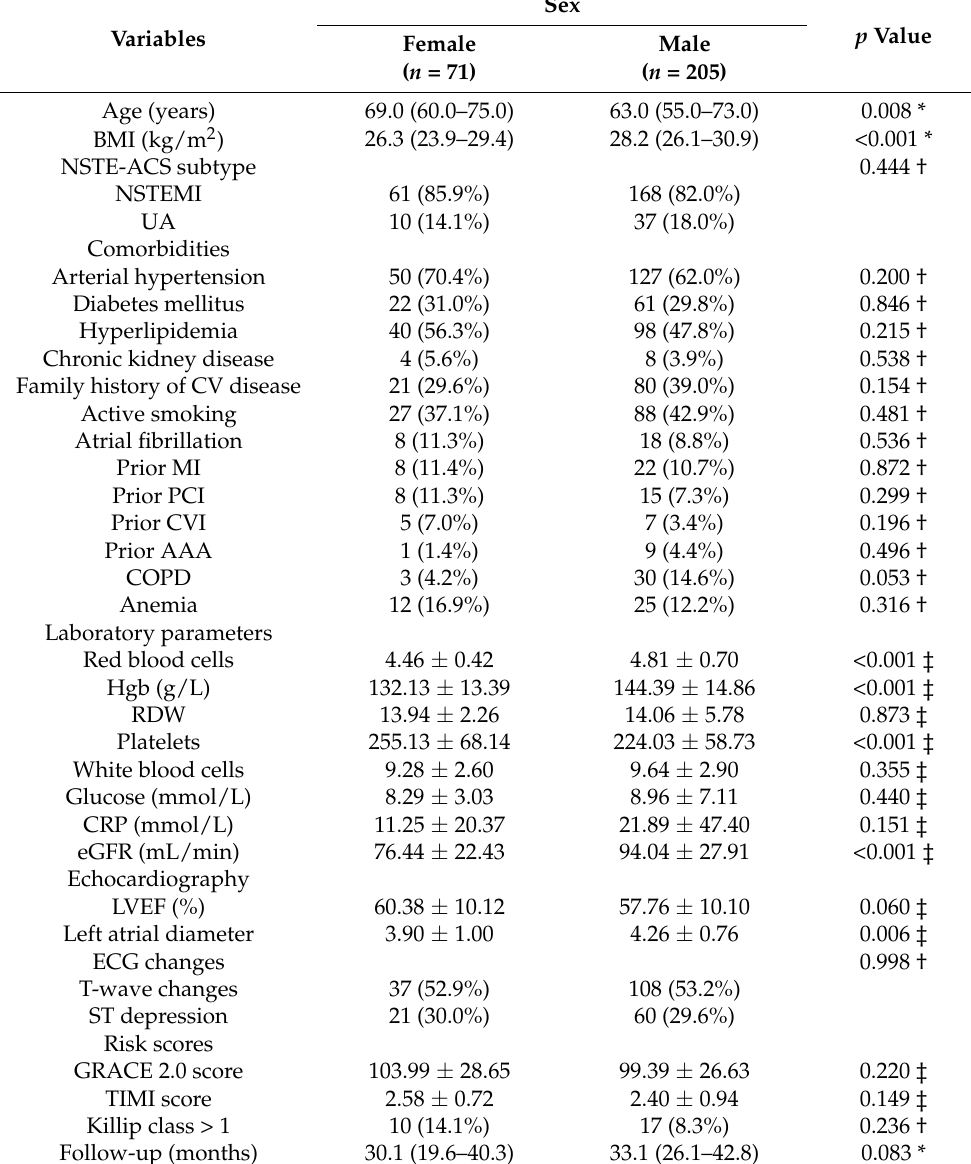
Table 1. Comparison of the baseline